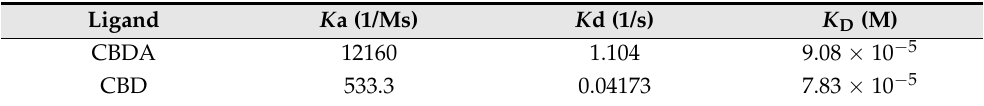
Table 4. M pro protein binding parameters ( K a, K d, and K D ) of CBDA and CBD obtained from the SPR experiments.